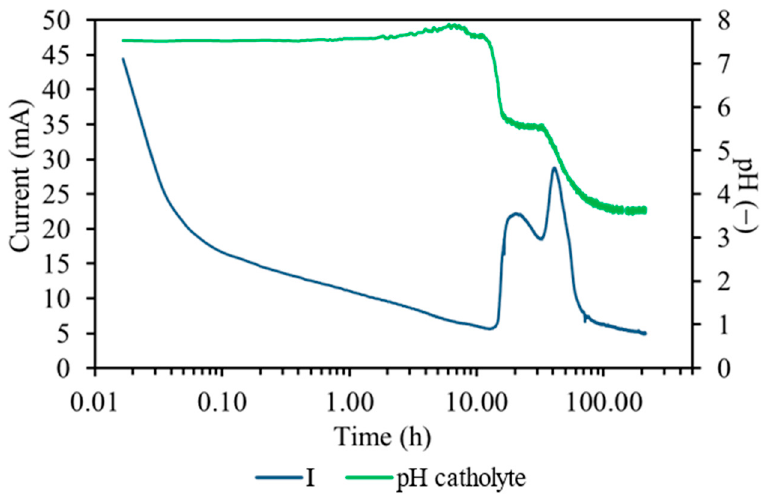
Figure 4. pH and electricity trends in Stage 1.